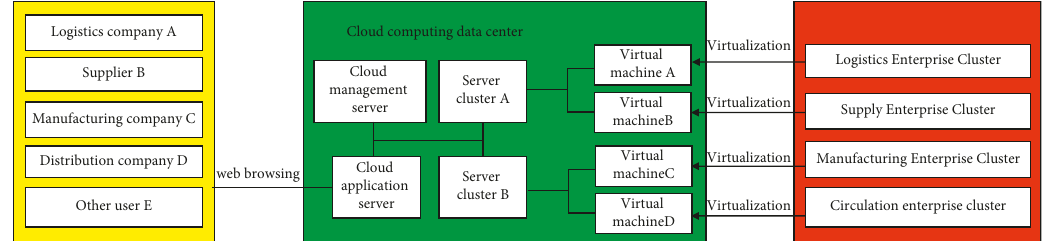
Figure 3: Physical architecture of logistics information intelligent analysis application platform based on cloud mining.